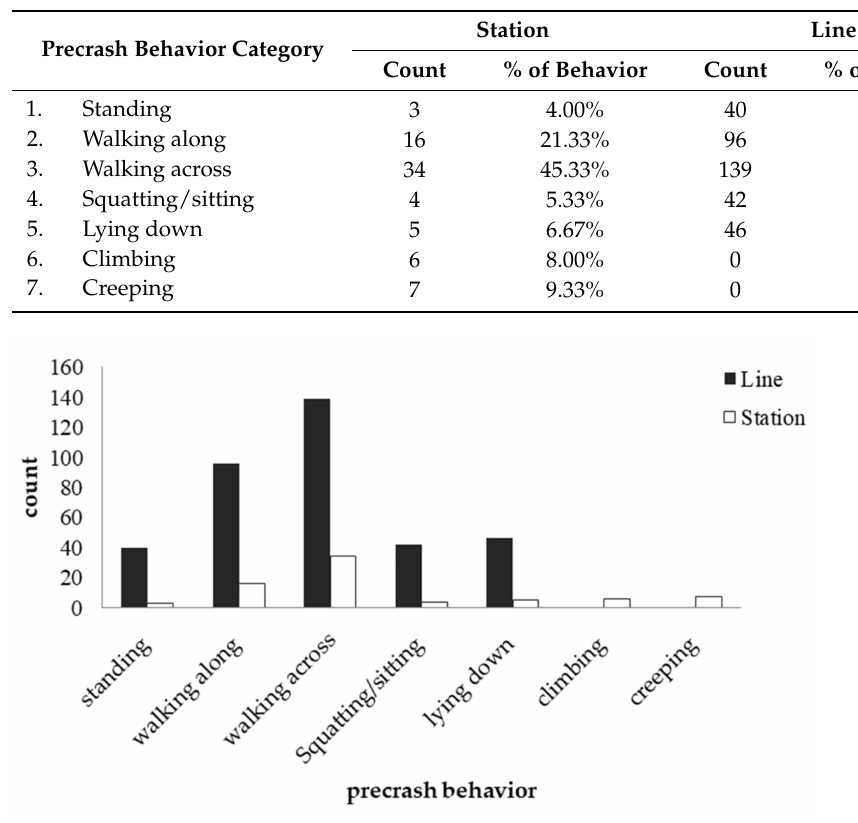
Figure 6. Collision frequency across different behaviors and